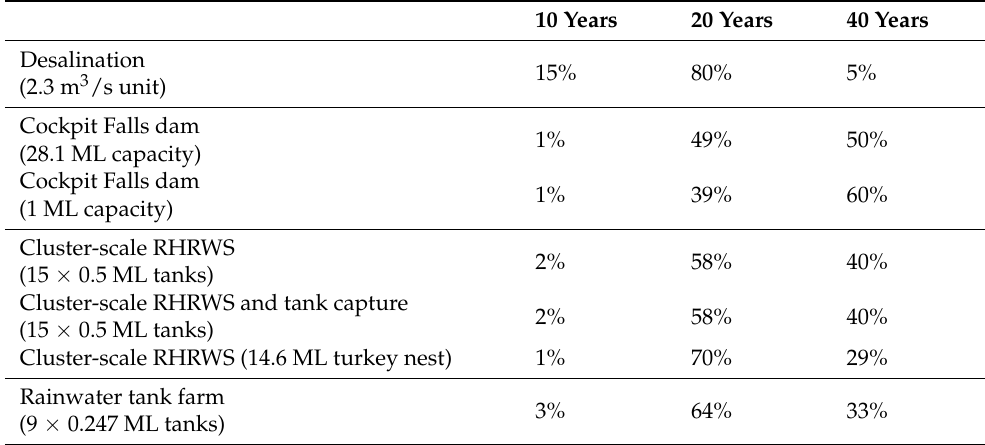
Proportion of infrastructure assumed to have 10-, 20- and 40-year service life for intervention